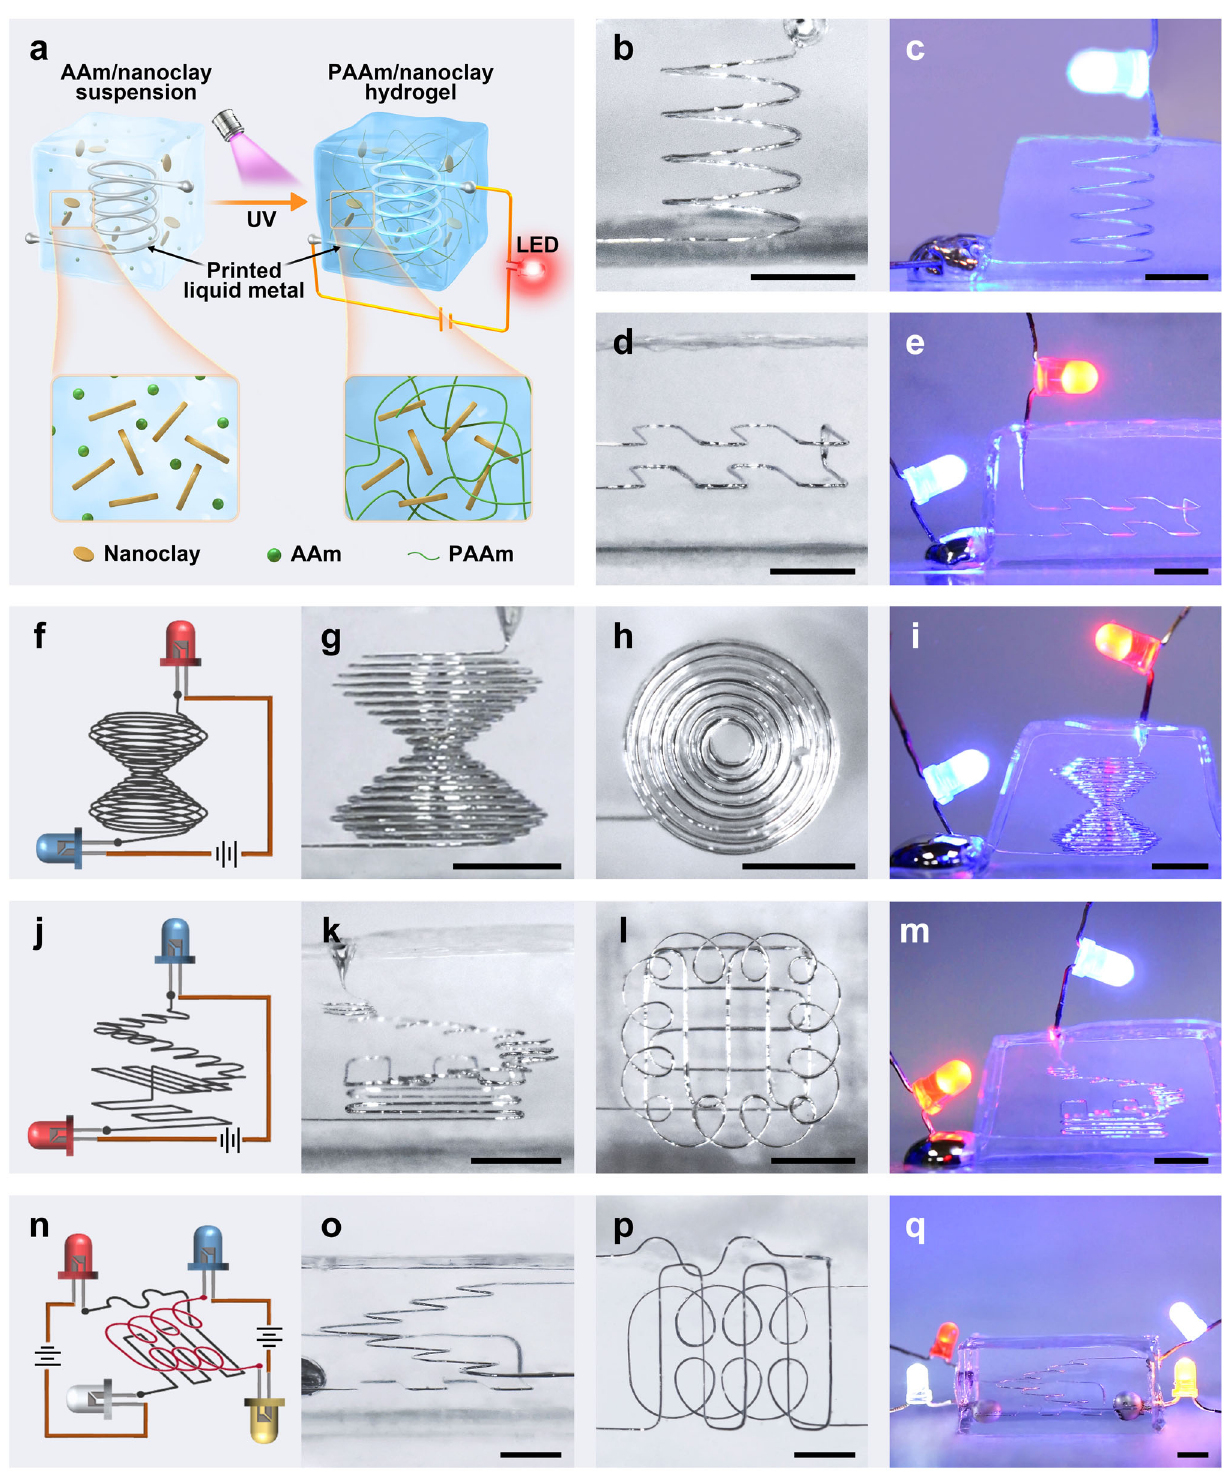
Fig. 3 Liquid metal-hydrogel electronics with printed dangling structures of liquid metal. a Schematic of AAm/nanoclay suspension polymerized into PAAm/nanoclay hydrogel under ultraviolet light after printing. b – q Printed 3D structures of liquid metal after printing and at work: b , c Circular helix structure. d , e Double-layered structure. f – i Hourglass structure. j – q Designed structures with one ( j – m ) or two ( n – q ) interlacing circuits. Scale bars: 5 compression strain or increased with tensile strain. Figure 5e larger 3D feature (greater P and H values), which demonstrated illustrates the change of the resonant frequency of resonant the ef fi ciency of a 3D resonant sensor for tensile and compression sensors under different values of strain. The response of the detection. For instance, at − 50% strain, the resonant frequency of resonant sensor to the same strain was more signi fi cant with a the resonant sensor with P = H = 2.4 mm decreased about 0.4 GHz